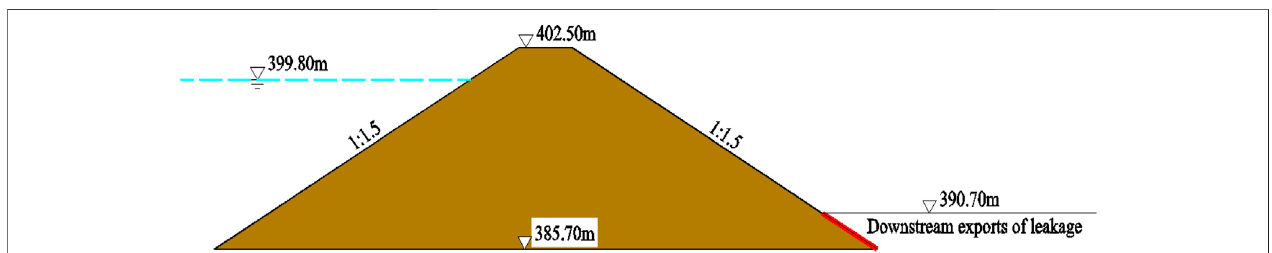
FIGURE 4 | Schematic diagram for leakage of the embankment dam slope (Ding et al., 2020).